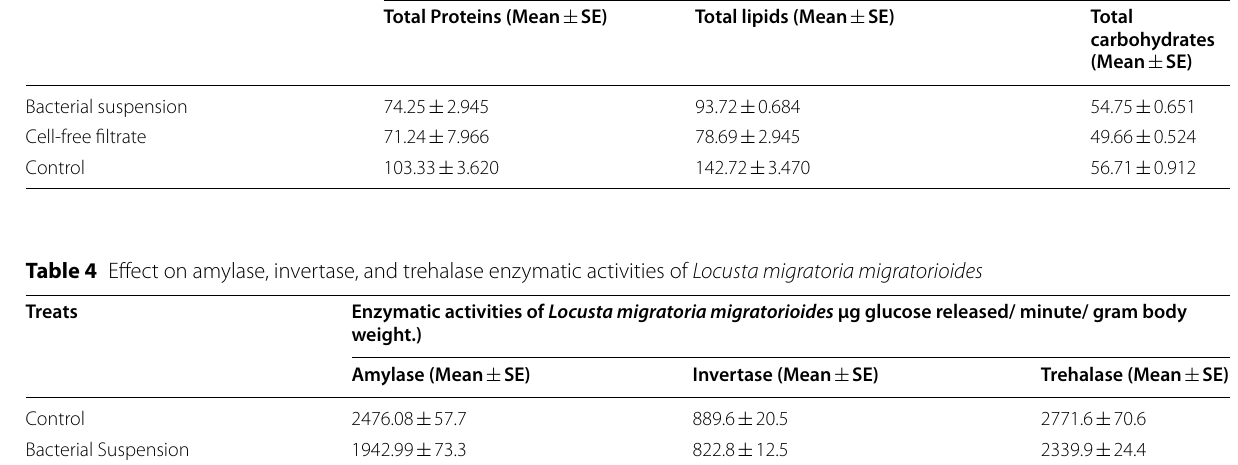
Table 3 Effect on total proteins, lipids and carbohydrates of Locusta migratoria migratorioides Treats